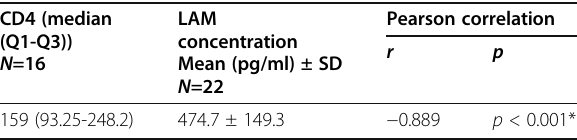
Table 5 Correlation between LAM concentration and